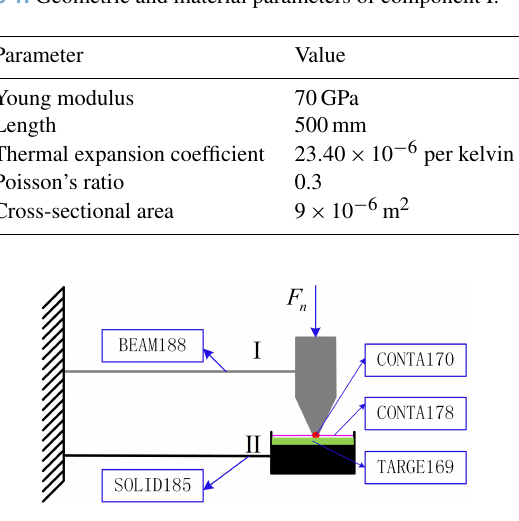
are used to simulate the horizontal contact between the com- ponents. A vertical force F n is applied to keep the compo- nents in contact